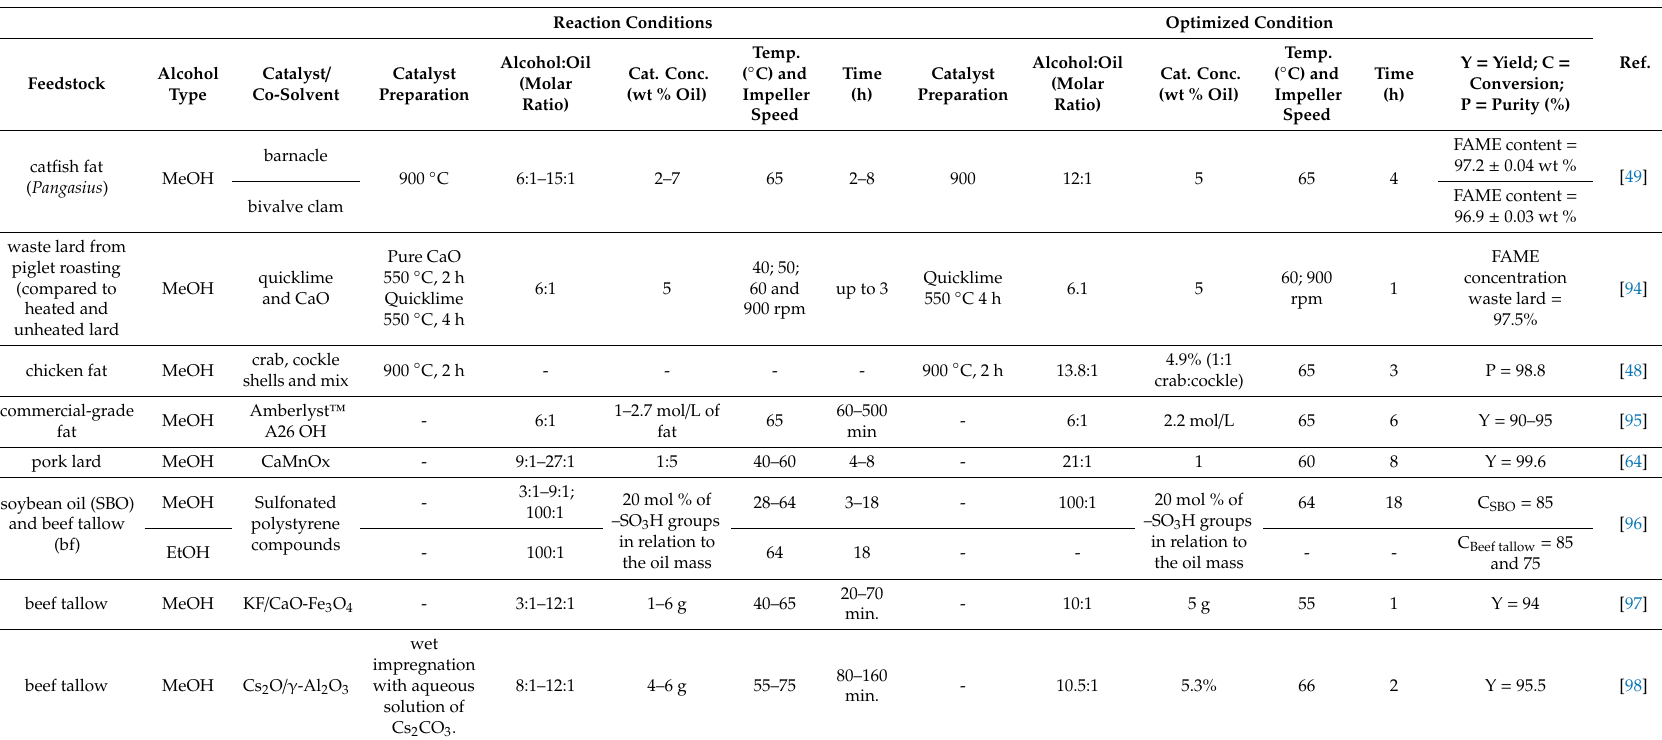
Table 7. Review of heterogeneous catalysis to processes animal